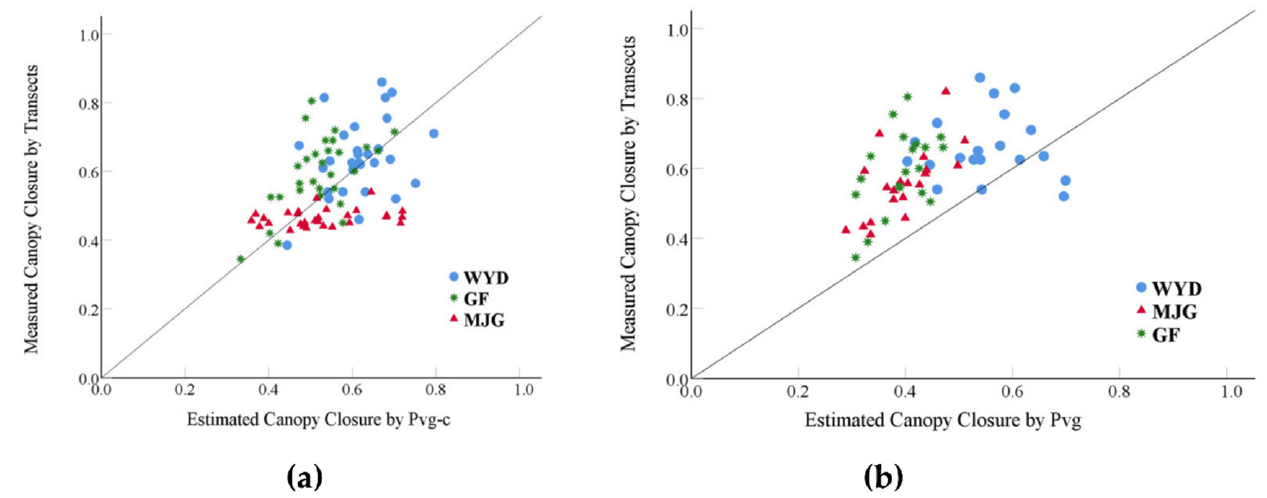
Figure 12. ( a ) The scattering plot of the canopy closure measured and estimated by P vg-c ; ( b ) the scattering plot of the canopy closure measured and estimated by P vg .